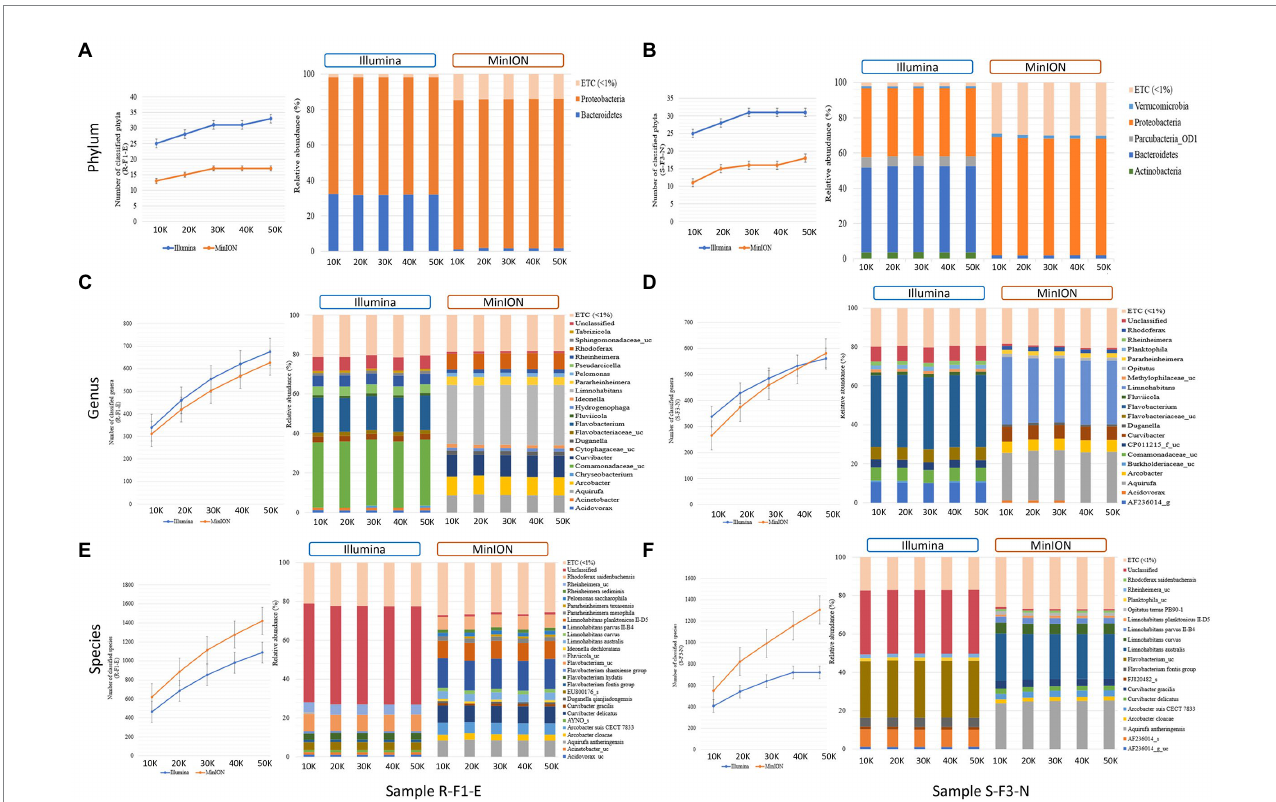
FIGURE 3 Comparison of (A) total number of classified phyla; (B) the phyla classified with > 1% relative abundance; (C) total number of classified genera; (D) genus classified with > 1% relative abundance; (E) total number of classified species; and (F) species classified with > 1% relative abundance from sample R-F1-E and S-F1-E sequenced using Illumina iSeq100 and Oxford Nanopore MinION at different input reads ranging from 10 K to 50 K. “ETC (< 1%) represents the classified reads at different taxonomic levels with < 1% relative abundance, whereas “unclassified” represents the relative abundance of the reads that remains unclassified at taxonomic